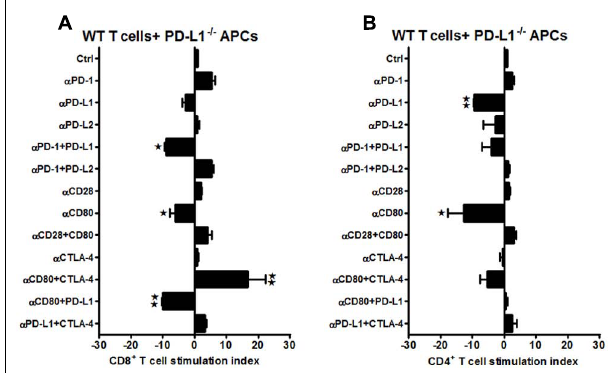
FIGURE 5 | Presence of PD-L1 onAPCs is as important as it is onT-cells, while expression of PD-L2 is crucial onAPCs ofWT mice subjected to MCAO. T-cells were purified, by negative sort, from the spleens of MCAO-subjectedWT mice, by labeling with specific microbeads and separating on the AutoMACS TM .The purifiedT-cells were CSFE-labeled and then cultured with non-T-cells from PD-L1 − / − mice at a 1:1 ratio (T:APC) in the presence of anti-CD3 antibody (2.5 μ g/mL; baseline) and other neutralizing Abs (10 μ g/mL) to co-stimulatory molecules, in 96-well plates. After 72 h of culture, cells were washed and evaluated by FACS Calibur for (A) CD8 + and (B) CD4 + T-cell expression and CFSE dilution. Data represent the stimulation indices of the CD8 and CD4T-cells in the presence of neutralizing Abs as compared to the control (T:APC + anti-CD3 Ab) condition).The data are represented such that the baseline value is 1 and all other values are adjusted relative to the baseline. Data presented are representative of splenocytes obtained from eightWT, six PD-L1 − / − , and six PD-L2 − / − mice with least three separate experiments and each experiment comprising duplicates or triplicates of the given neutralizing Ab condition. Significant differences between sample means are indicated as * p ≤ 0.05, ** p ≤ 0.01 as compared to the baseline